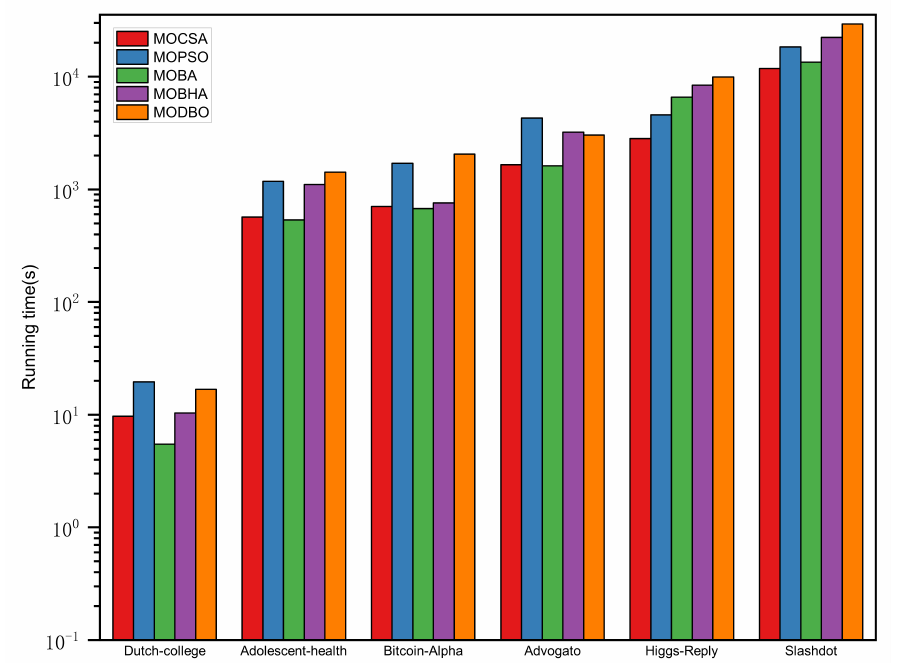
Figure 8. Comparison of fitness of different algorithms on six real social